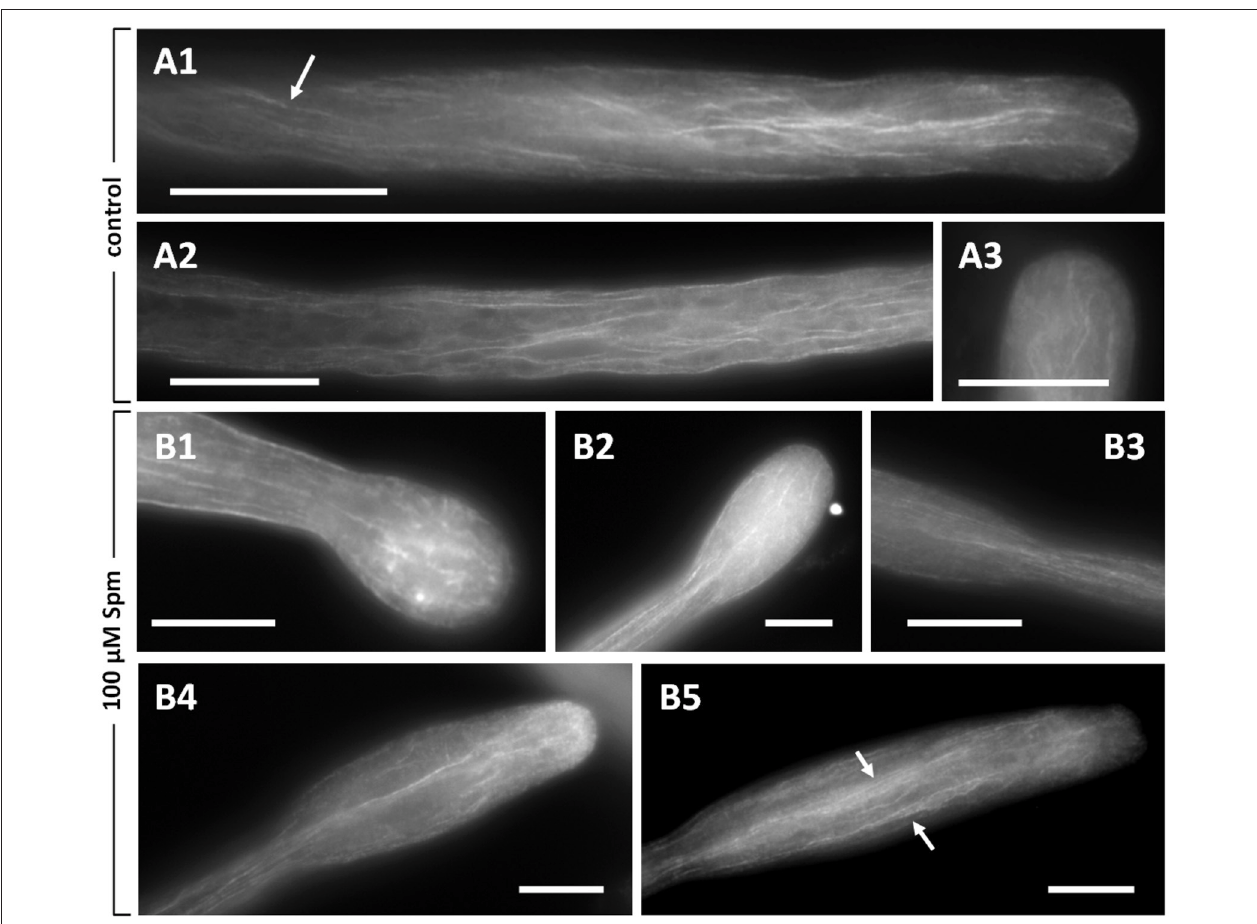
FIGURE 5 | Distribution of actin filaments in pear pollen tubes. (A1,A2) Control pollen tubes. The arrow indicates a longitudinal helicoidally-arranged actin filament. (A3) Detail of a control pollen tube apex. (B1–B5) Pollen tubes treated with Spm. (B1) A balloon-shaped pollen tube showing completely disorganized actin filaments in the apex. (B2) Reorganization of actin filaments at the snake-shaped stage. (B3) When the pollen tube re-starts to grow, actin filaments run along the cortical region and open like a fan at the neck level. (B4,B5) Actin filaments can be observed as the new shovel-shaped pollen tube resumes growth. Arrows indicate some actin bundles that run longitudinally along the middle and the cortex of pollen tubes. Bars = 10 µ m. Data are representative of three independent